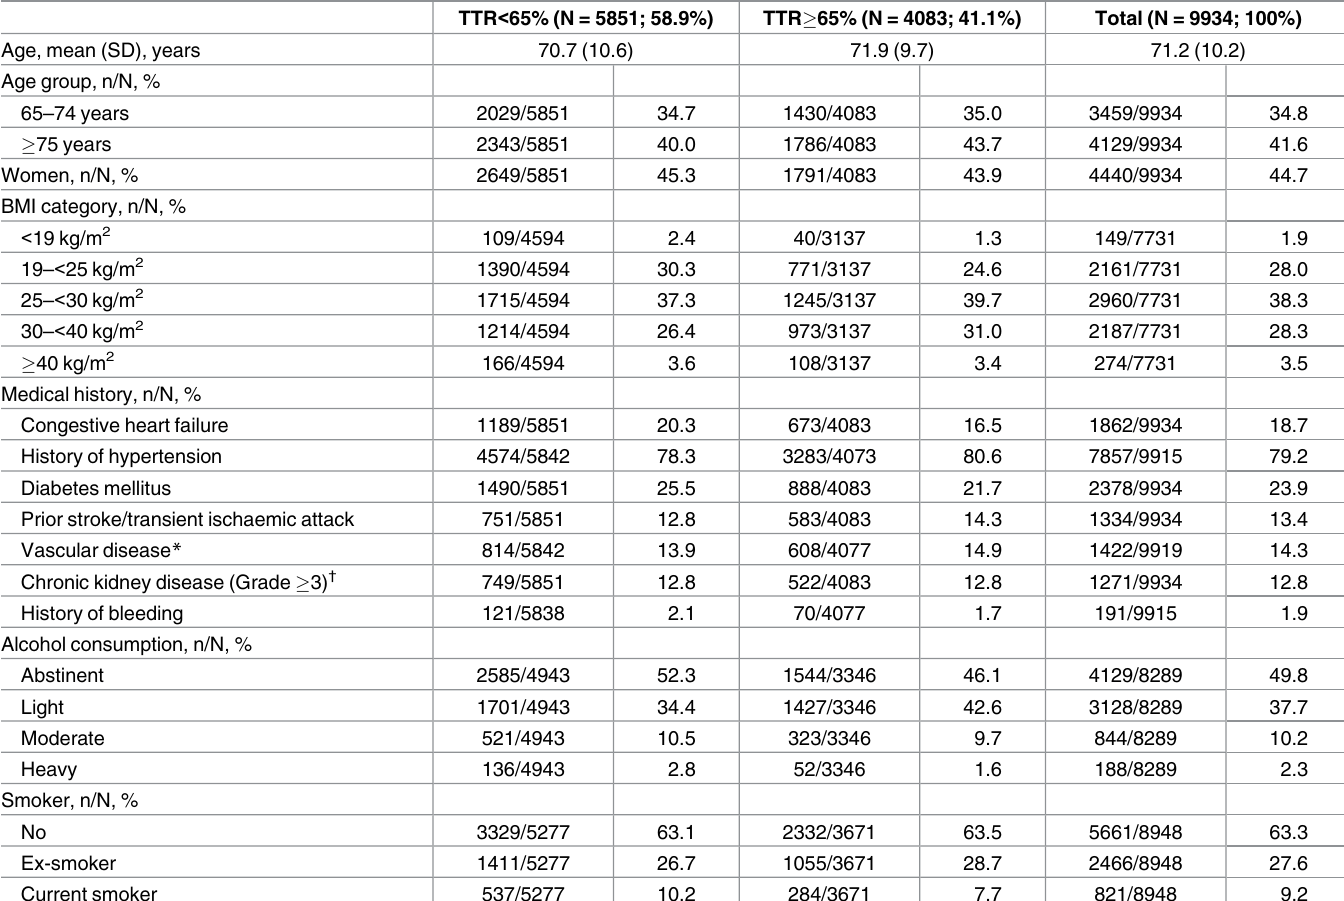
Table 1. Baseline characteristics of patients according to proportion of time in therapeutic range.